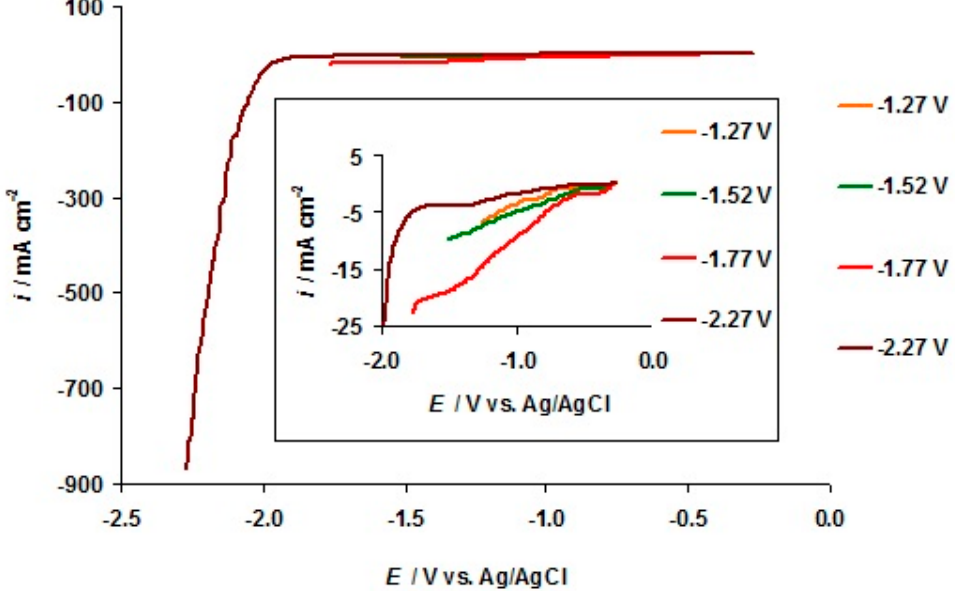
Figure 6. Potential linear sweep (LS) data recorded for negatively polarized C fiber microelectrode soaked in the 5 wt % EMImBr solution in EMImBF 4 . Second sweeps moving toward more negative potentials are shown, measured at the normal pressure in the Ar-filled glove box conditions. Potential sweeps started at E = − 0.27 V and ended at the potentials indicated in the figure; the potential scan rate was 1.0 mV s − 1 . The inset represents the zoomed in part of the LSs shown above.